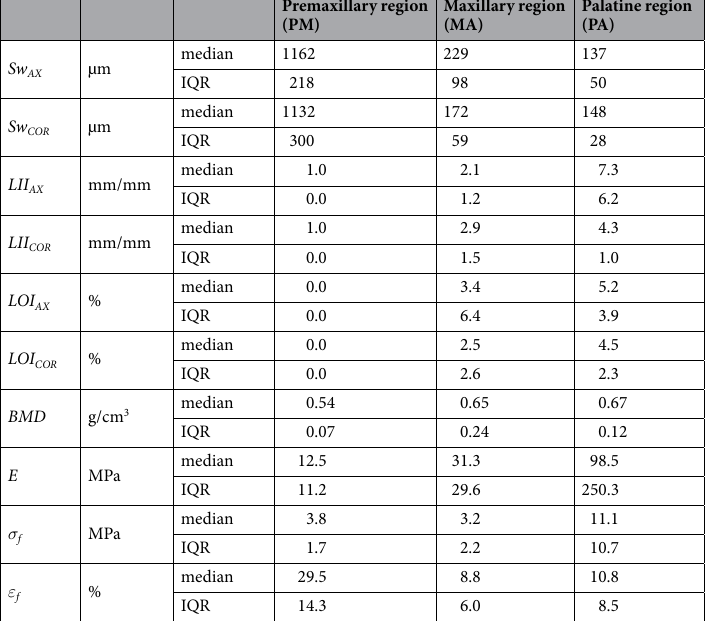
Table 1. Values of the anatomical and mechanical parameters. IQR = interquartile